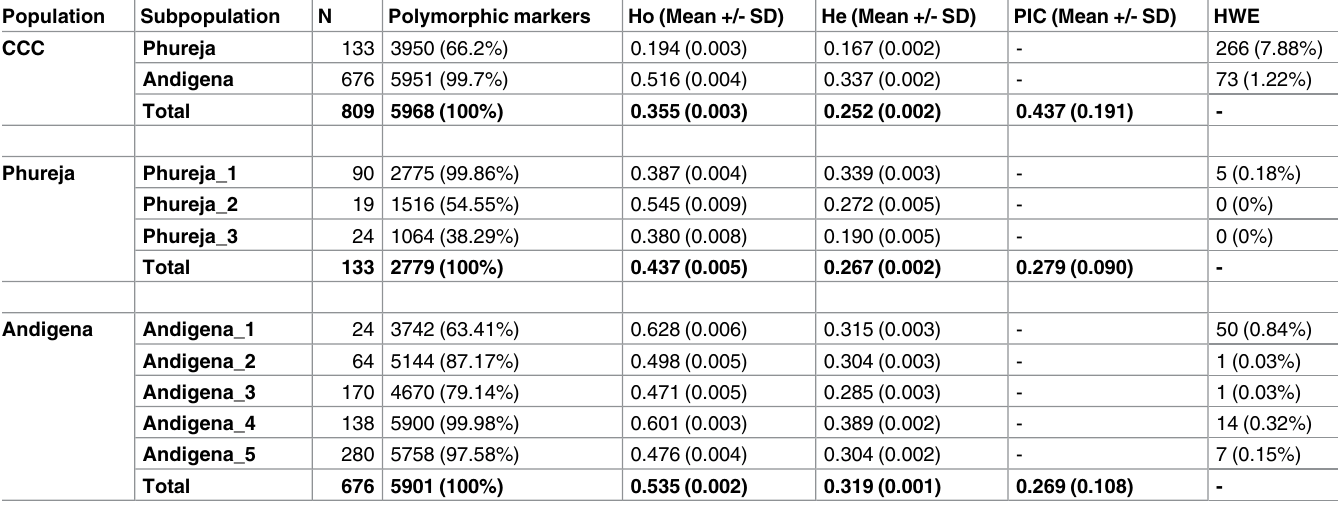
Table 3. Genetic diversity statistics of the Colombian Central Collection of S . tuberosum group Andigenum.